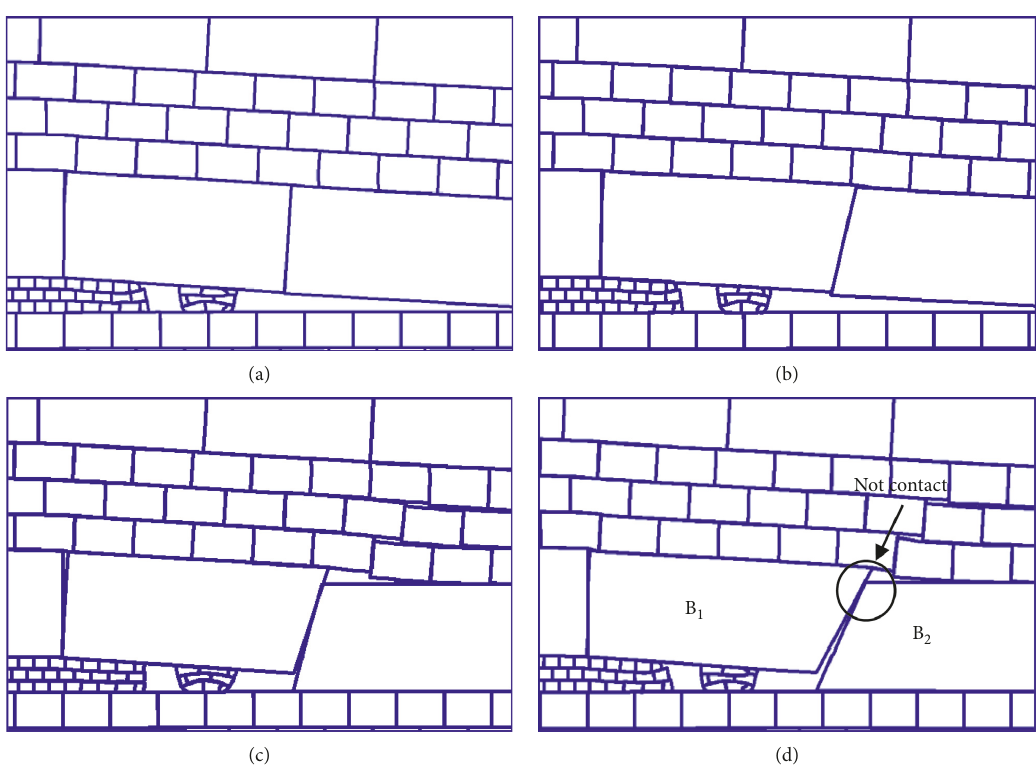
Figure 8: Variations of the roof structure with different cutting angles: (a) 0 ° , (b) 10 ° , (c) 15 ° , and (d) 25 °